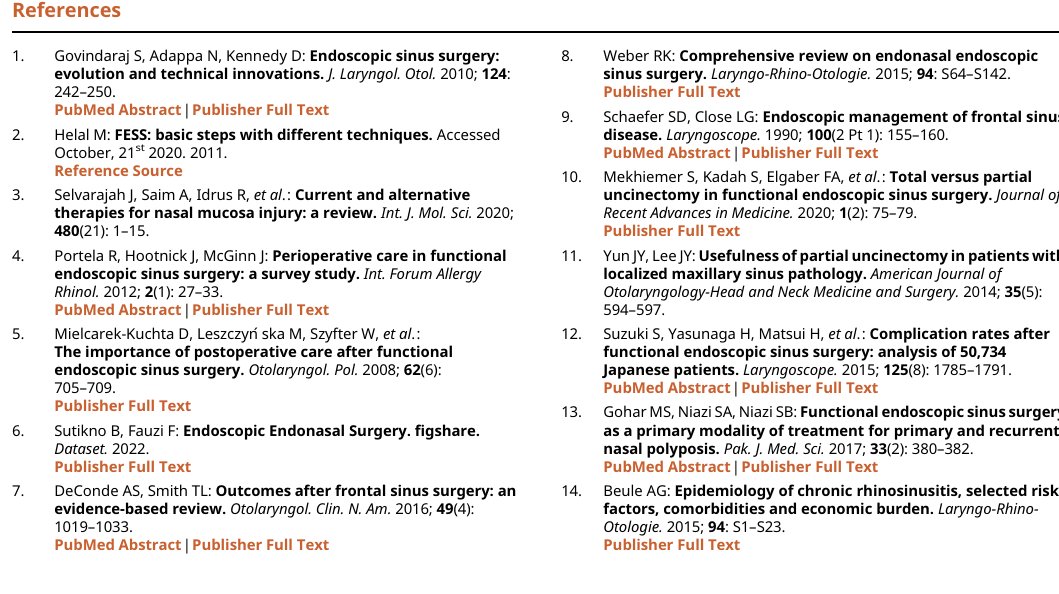
Figshare: Differences in the length of postoperative care of endoscopic endonasal surgery in simple and complex surgical procedure groups 10.6084/m9.figshare.19210806